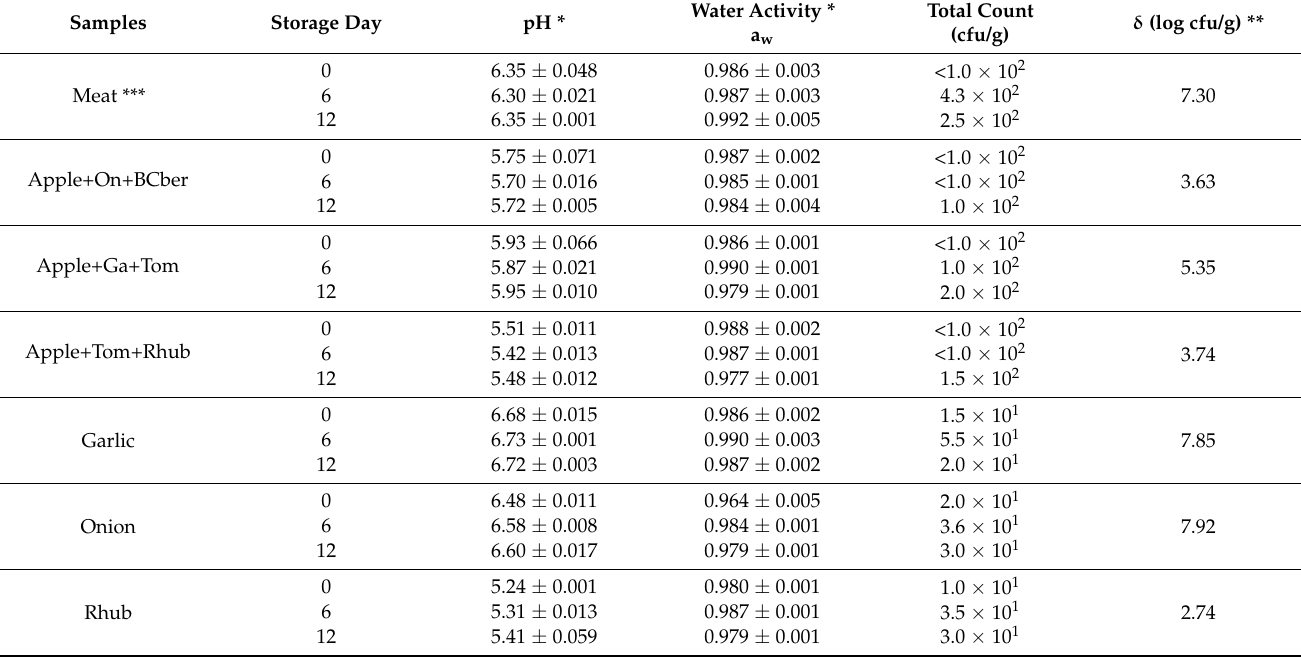
Table 4. Results of challenge tests of cooked meat